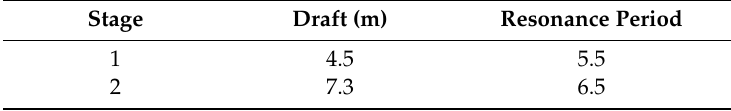
Table 4. Operation level of the self-adjustable wave energy